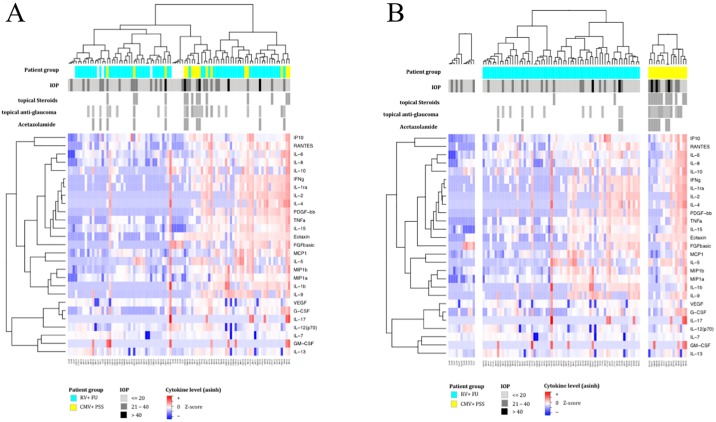
Cluster analysis of aqueous cytokine levels in Posner-Schlossman-Syndrome (PSS), Fuchs´Uveitis (FU) patients, and control group.The measured values of analyzed concentration are represented in heatmaps with colors according to (per-analyte) mean-centered and sigma-normalized data (Z-score) after asinh transformation of the raw values. The height of the dendrogram represents the dissimilarity between clusters of patient samples (columns) according to the profile of secreted immune mediators (rows). The top-bars indicate the PSS (yellow), the FU (cyan) and control group (white), as well as IOP level of each individual (light grey: IOP< = 20, grey: IOP>20, black: IOP>40), topical steroid treatment (white: no treatment), topical anti-glaucoma treatment (white: no, light grey: Brimonidine/Timolol, grey: Dorzolamide/Timolol), and systemic anti-glaucoma treatment with acetazolamide (white: no treatment). A) Simultaneous analysis of data from all three groups indicates that one part of PSS group with high IOP and low levels of mediators fall into a single cluster with a distinct immune mediator expression profile. B) Clustering performed in each group separately shows that within the PSS group patients with mostly low levels of mediators have also high IOP and have been treated with acetazolamide.